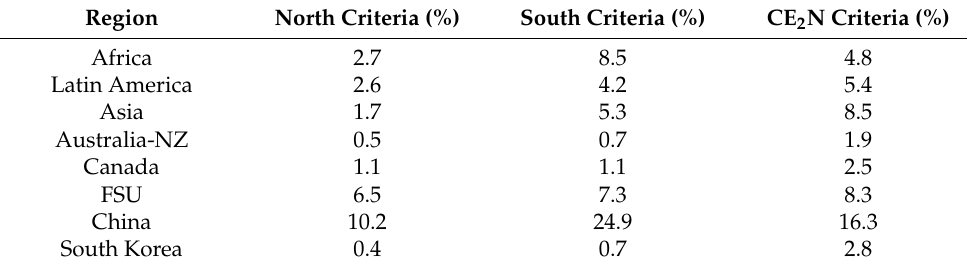
Table 12. Vaillancourt results vs. CE 2 N results. Own